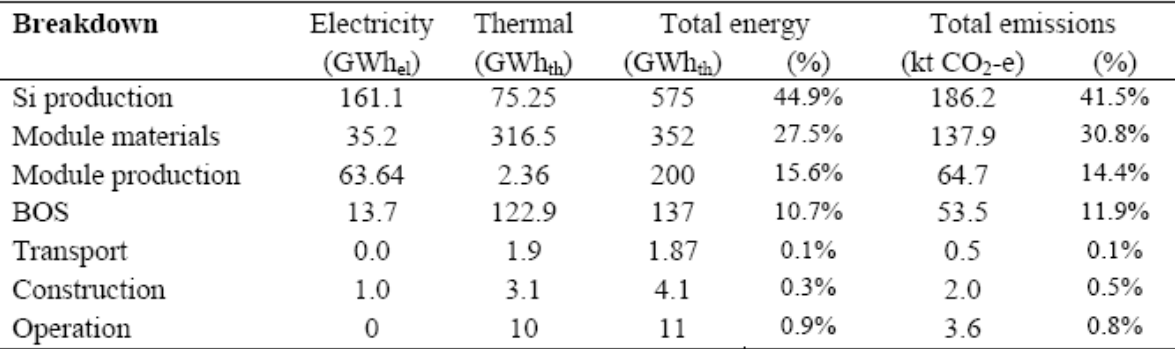
Table 8. Energy requirements and greenhouse gas emissions for a hypothetical 100-MW PV plant operating under Australian conditions. BOS = Balance Of System. © 2006 ISA, reproduced from [47] with